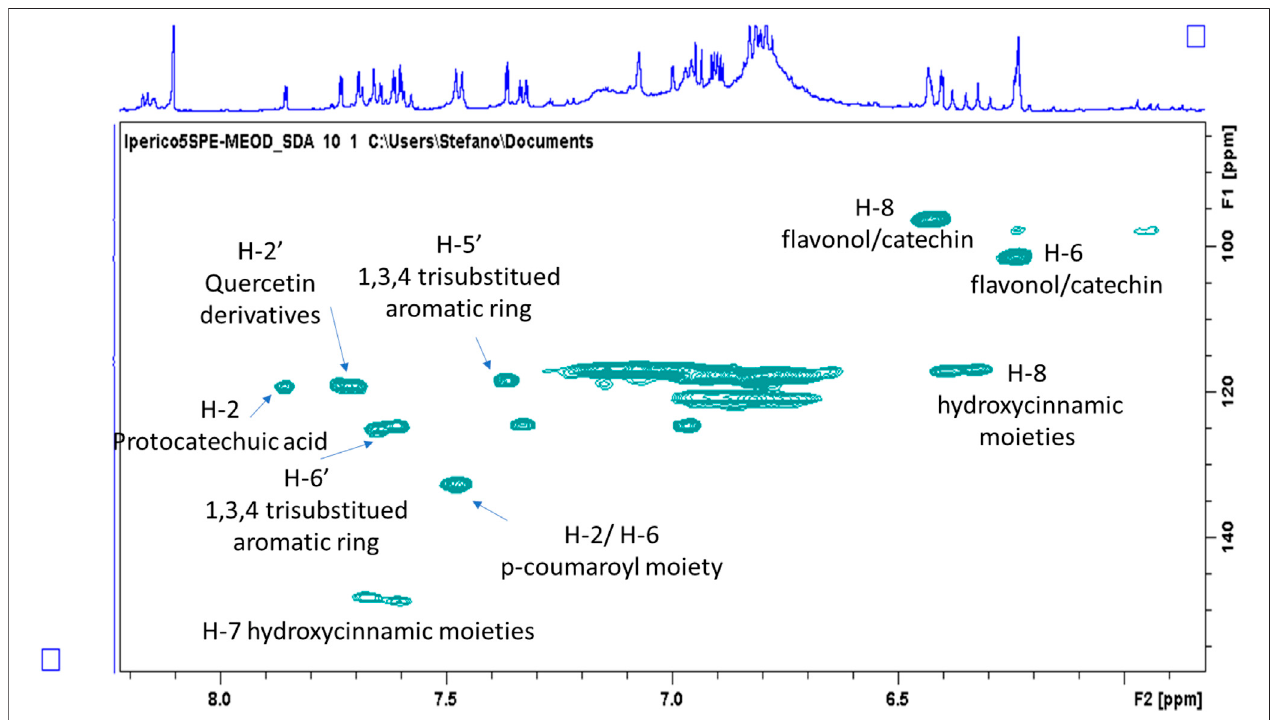
FIGURE 1 | Enlargement of the HSQC-DEPT of the methanol/water (50 – 50%) ATM fraction with highlighted resonances assigned to principal classes of phenolic constituents.